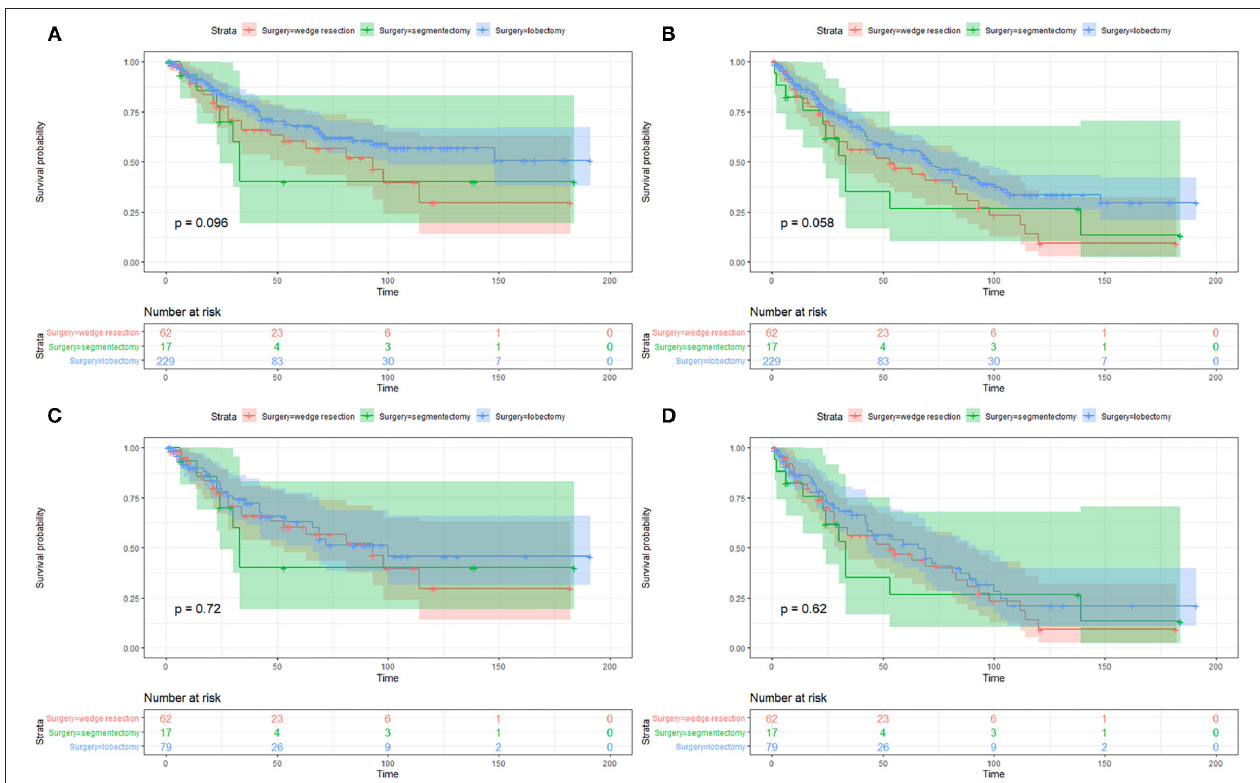
FIGURE 2 | Kaplan–Meier survival curves of cancer-specific survival (A,C) and overall survival (B,D) between patients with wedge resection, segmentectomy, and lobectomy before and after propensity score matching.